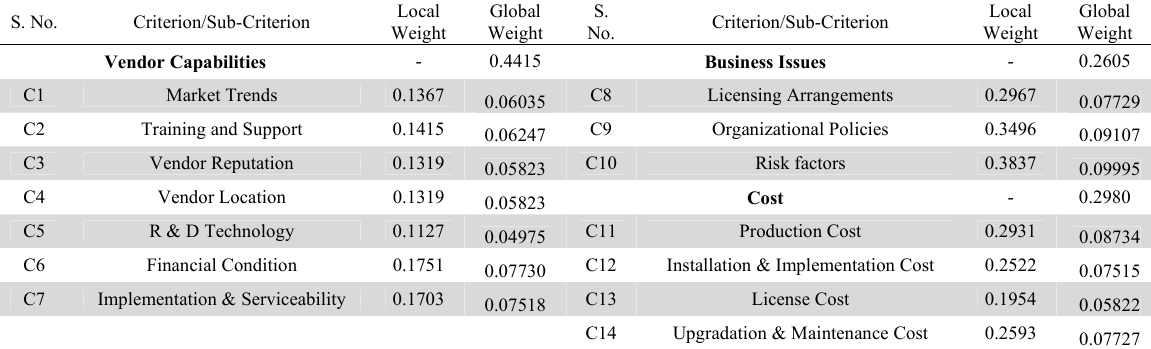
Weights (Local and Global) for evaluation criteria